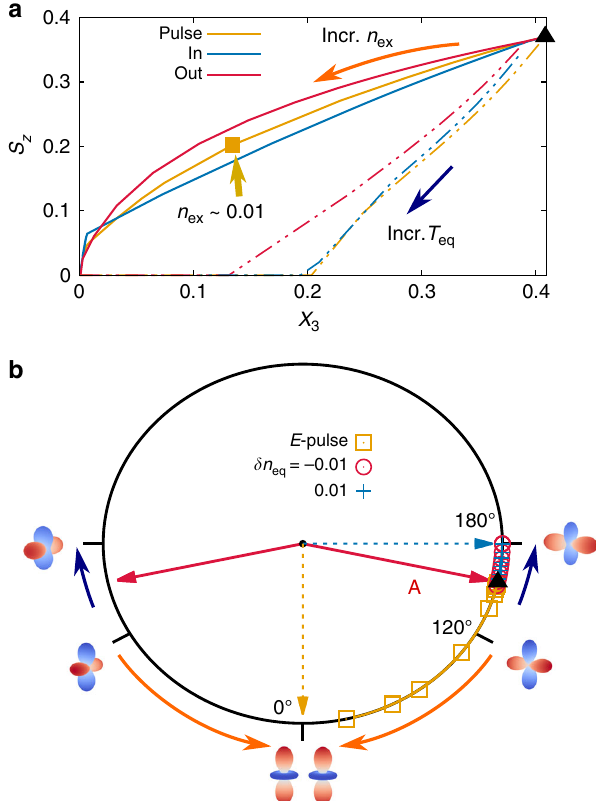
Fig. 3 The extrapolated spin and orbital order in the long-time limit. a The three different non-equilibrium protocols (electric fi eld pulse, photo-doping in/out electrons) all lead to stronger spin-ordering than orbital-ordering, which is qualitatively different from the behavior of the equilibrium system with increasing temperature (yellow double-dotted line) at integer fi lling and for the chemically doped systems with δ n = ±0.01 (red/blue double- dotted lines). b Normalized orbital-order components X 1 and X 3 in the long- time limit shown on the pseudospin compass. Rising equilibrium temperature and photo-excitation cause the orbital pseudospin to rotate in opposite